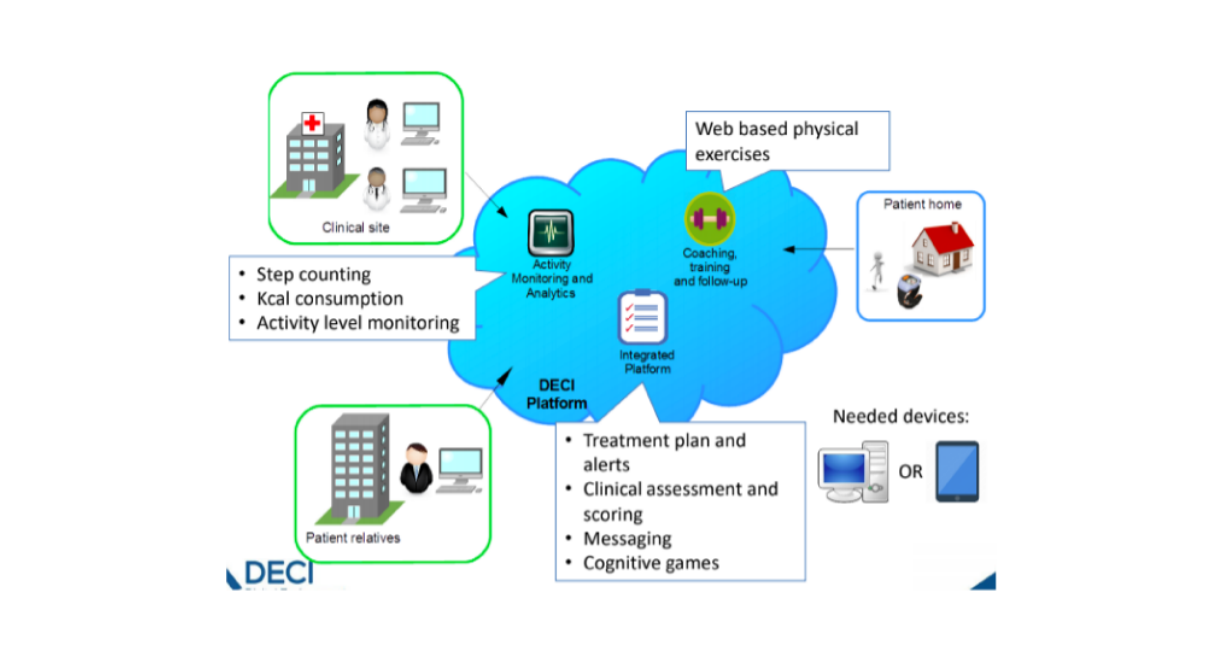
Figure 1. Components of the Digital Environment for Cognitive Inclusion (DECI)